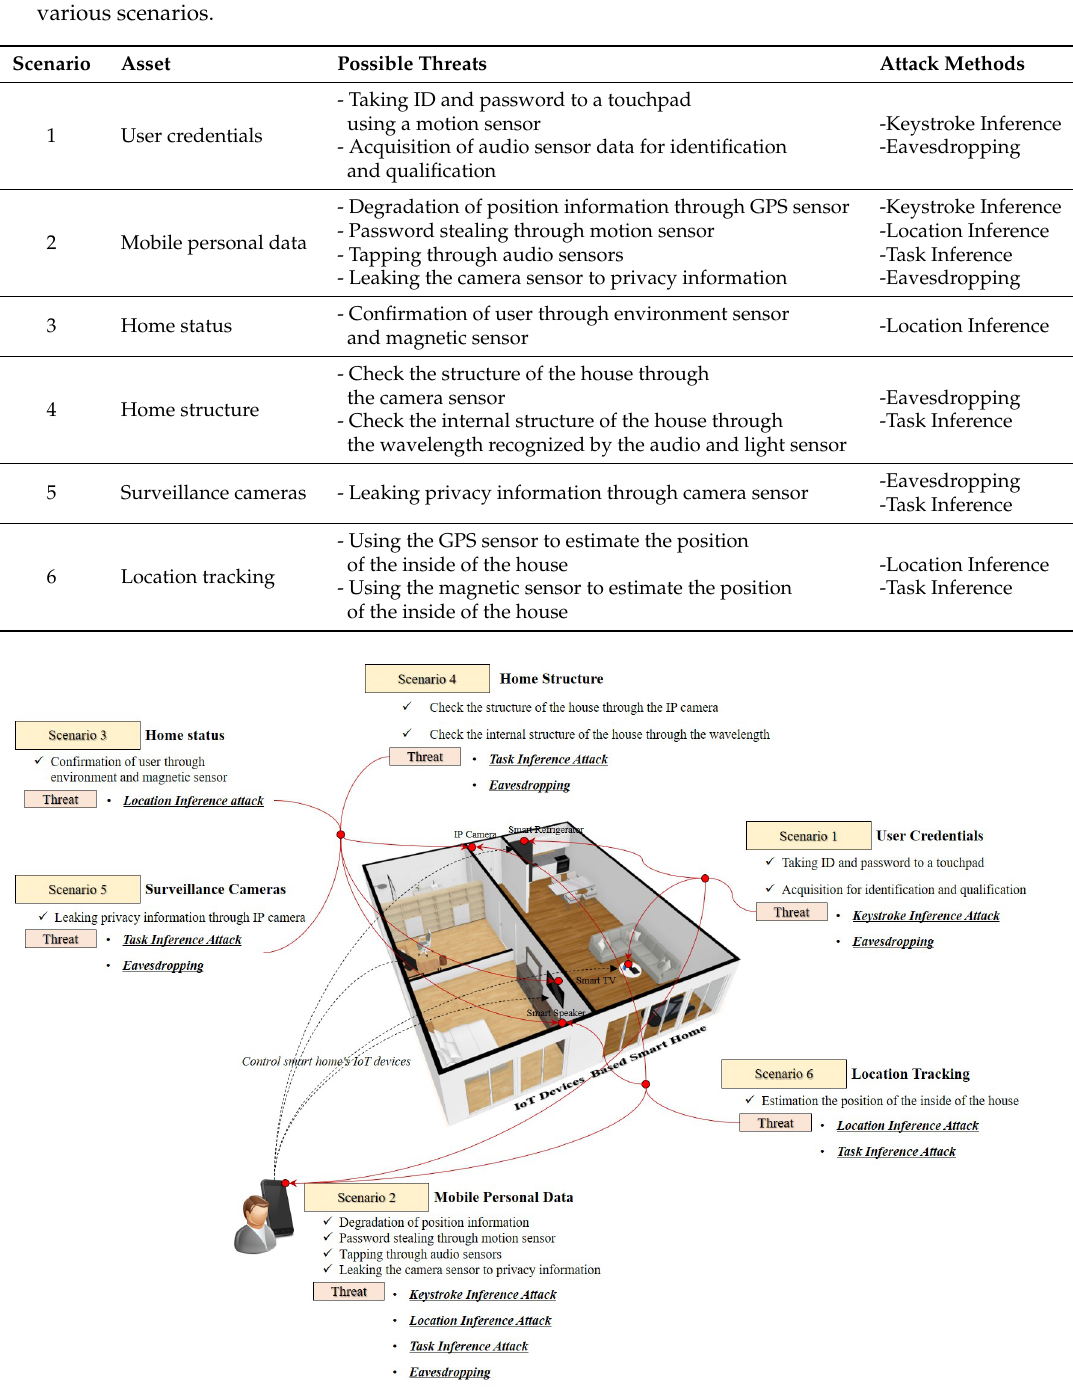
Figure 5. Sensors in IoT devices installed in smart homes can be used as information leakage